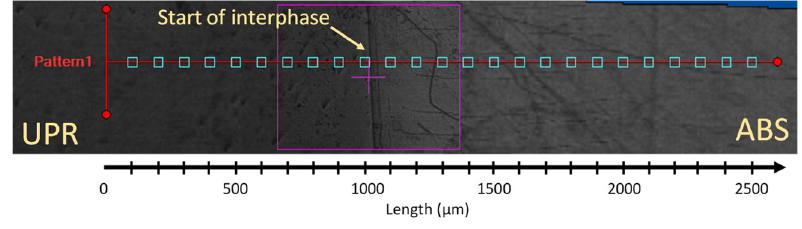
Figure 4. Vickers microhardness measurement pattern and sample